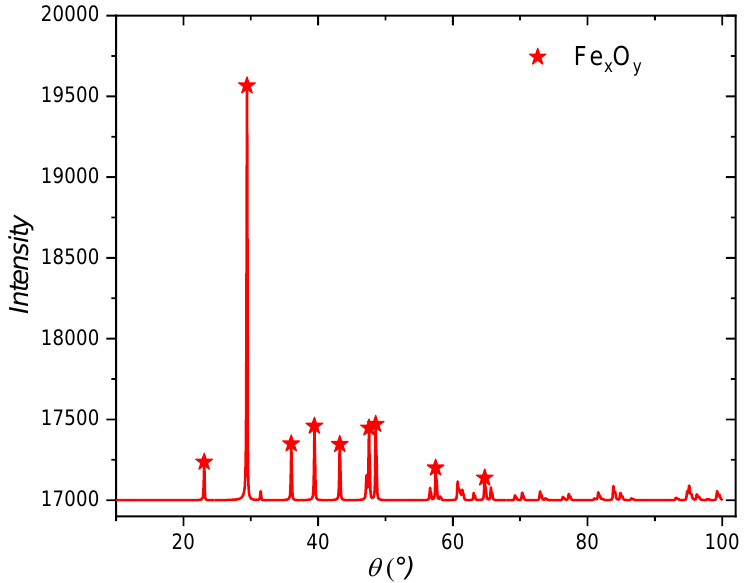
Figure 6. XRD analysis of the obtained catalyst after the pyrolysis process.